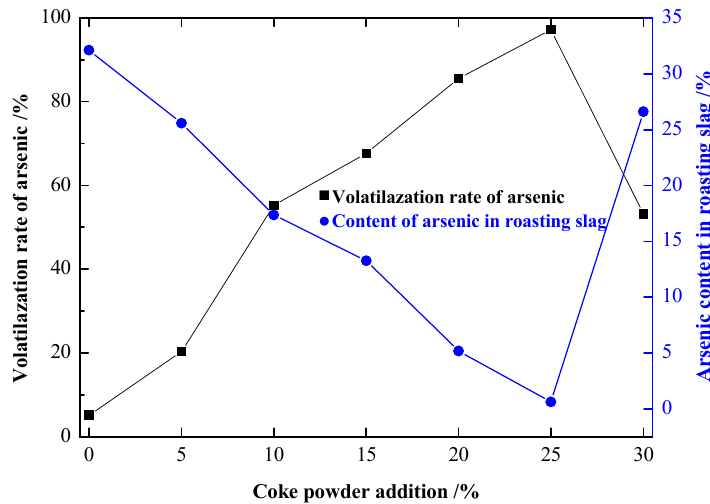
Figure 7. Influence of coke powder addition on the experimental results.